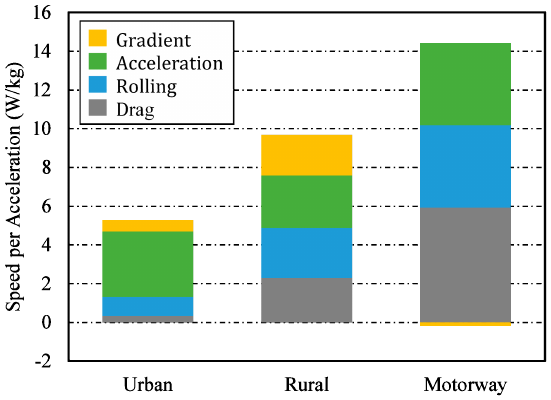
Figure 7. Composition of the v·a eng _(mean).